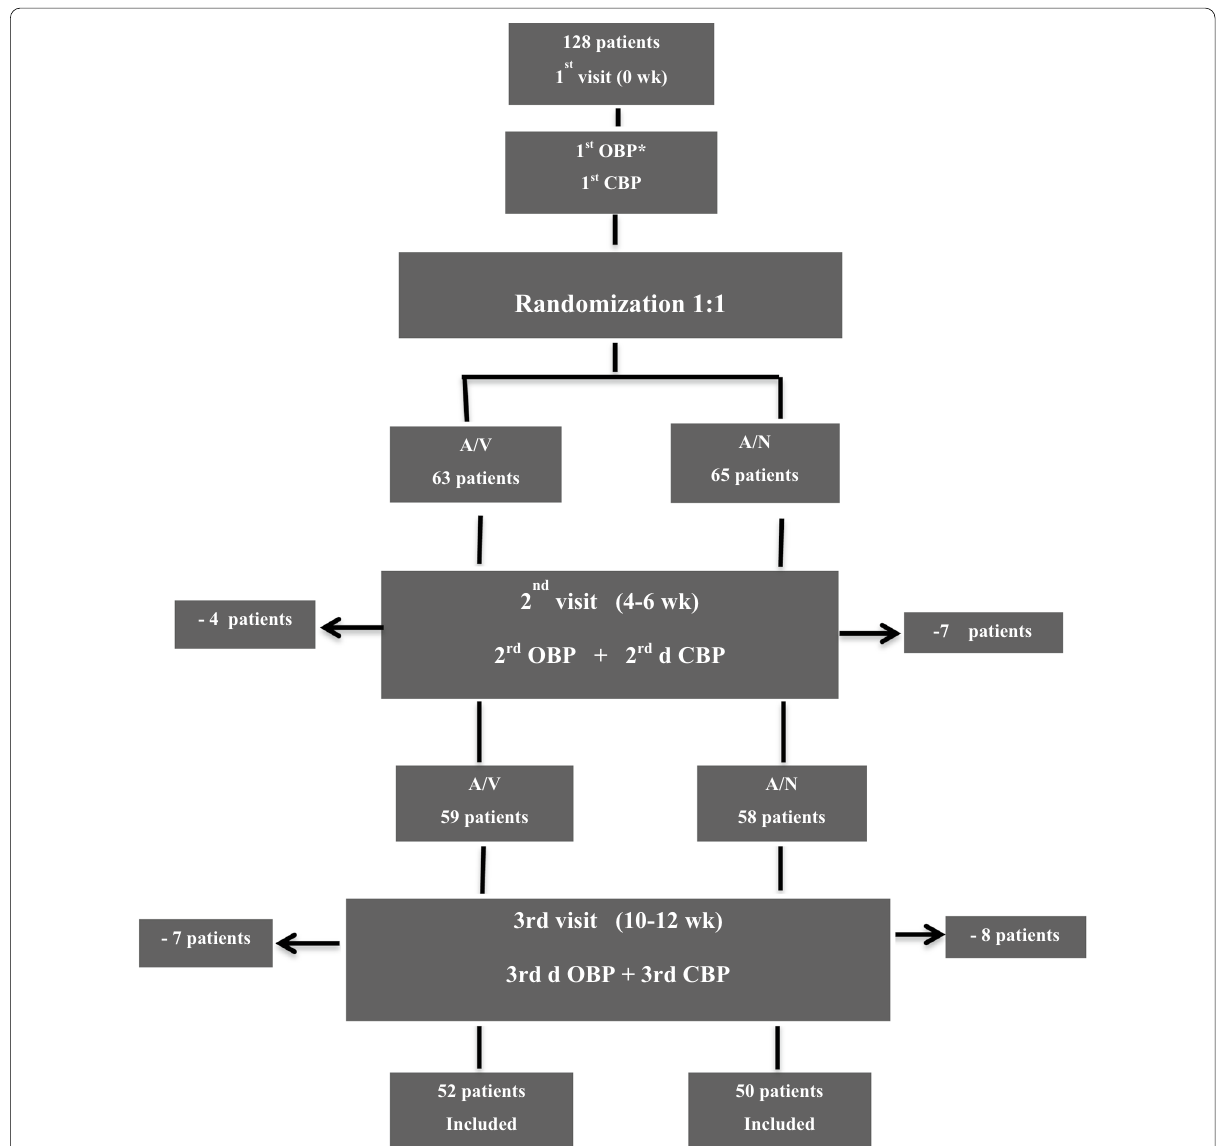
Fig. 1 Study protocol. *Diagnosis is permitted by office BP using calibrated mercury sphygmomanometer for all patients and by Mobil‑O‑Graph for